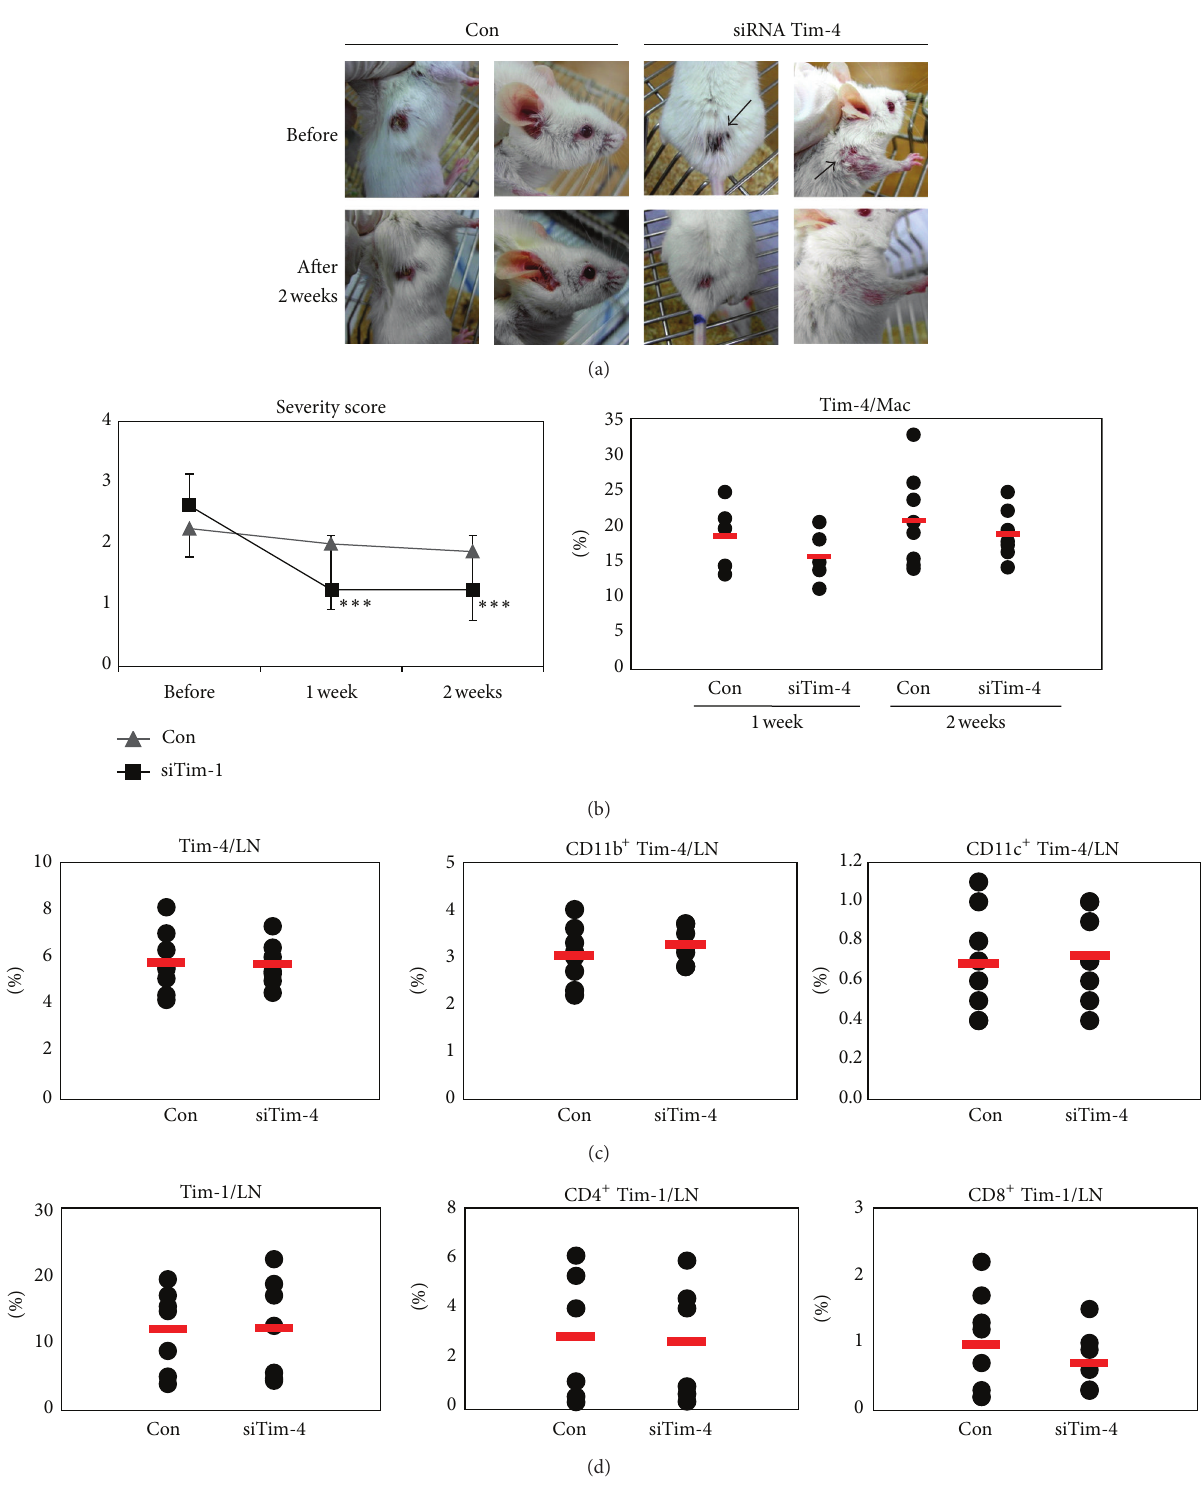
Figure 8: Behc¸et’s disease (BD)-like symptoms were changed after siTim-4 administration. Five 𝜇 g/mouse of Tim-4 siRNA was injected intraperitoneally three times at 2 day intervals into BD mice and they were observed for 2 weeks. (a) Photographs of mice taken before and at 1 and 2 weeks after treatment with siTim-4 and the control treated group (Con: negative control siRNA treated groups). (b) The severity score was compared before and at 1 and 2 weeks after treatment between the siTim-4 and control treated groups. The frequencies of Tim-4 + cells in peritoneal cavity were compared between the siTim-4 and control treated groups. (c, d) The frequencies of Tim-4 + , CD11b + Tim- 4 + , CD11c + Tim-4 + , Tim-1 + , CD4 + Tim-1 + , and CD8 + Tim-1 + cells in LN were compared to the siTim-4 and control treated groups ( 𝑛 = 7-8) ( ∗∗ 𝑃 < 0.05 ). Con: negative control injection to BD mice, siTim-4: Tim-4 siRNA injection to BD mice, LN: lymph